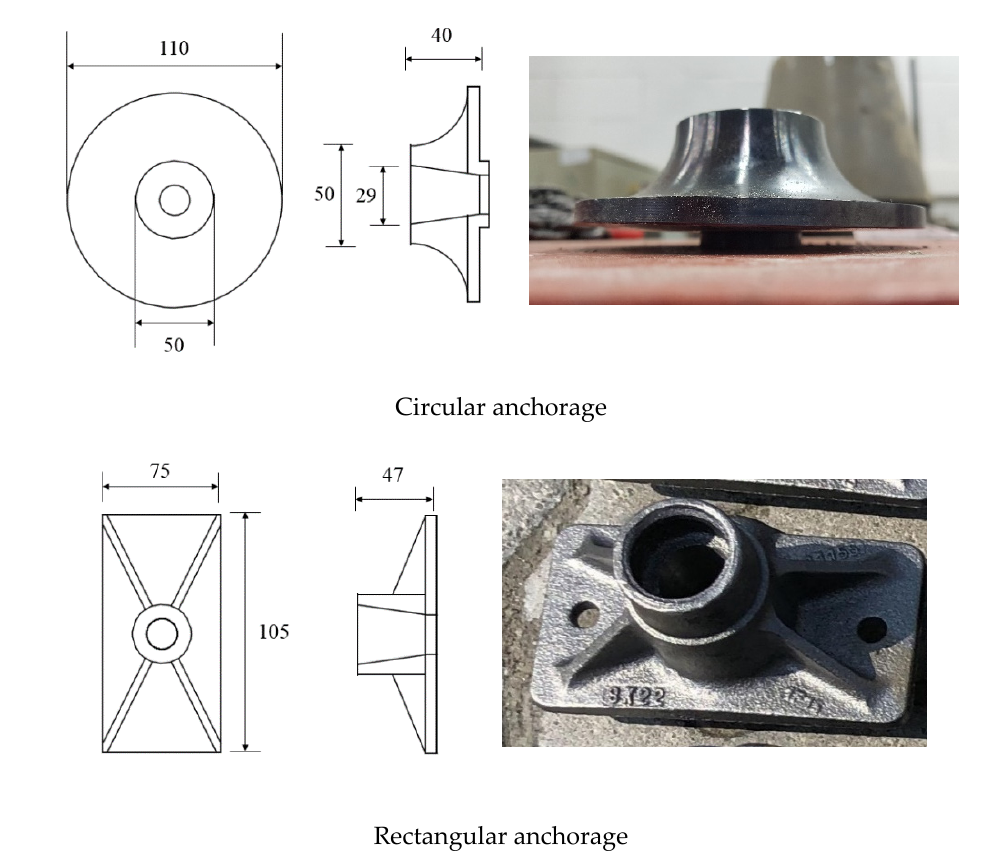
Figure 2. Notations of specimens.